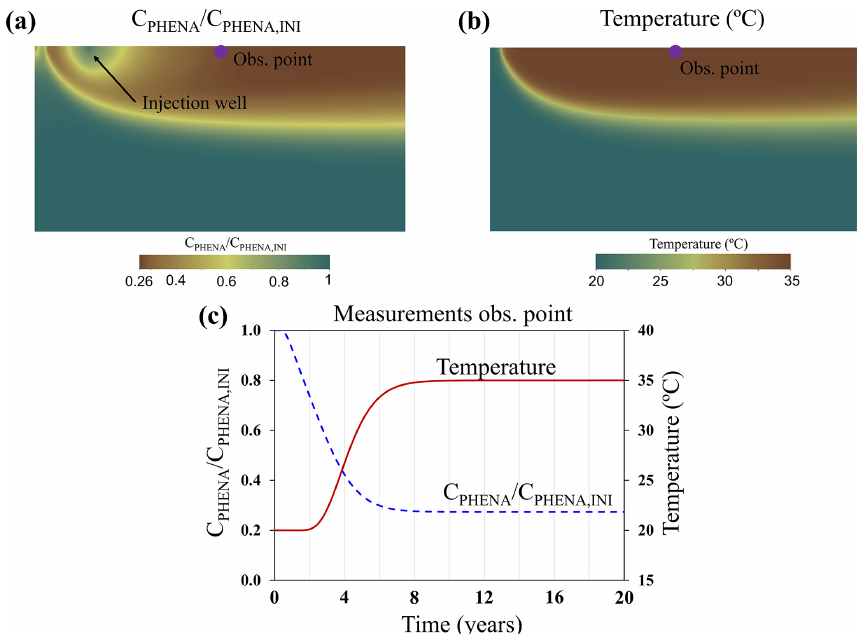
Figure 2. Distribution of normalized concentration of phenazone (a) and groundwater temperature (b) at the end of the simulated period (i.e., 20 years). (c) Evolution of normalized concentration of phenazone (blue dashed line) and groundwater temperature (red continuous line) at the observation point located 500m away from the injection well in the downgradient